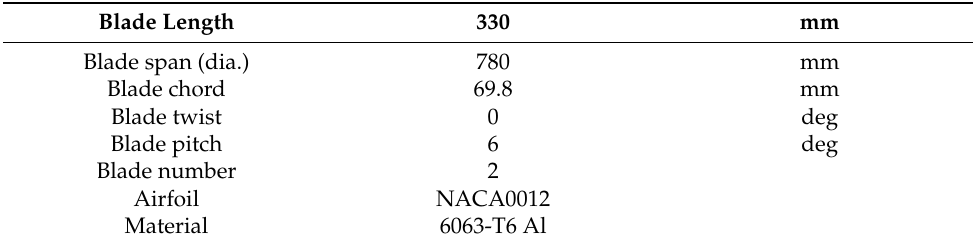
Table 1. SRB blade characteristics.